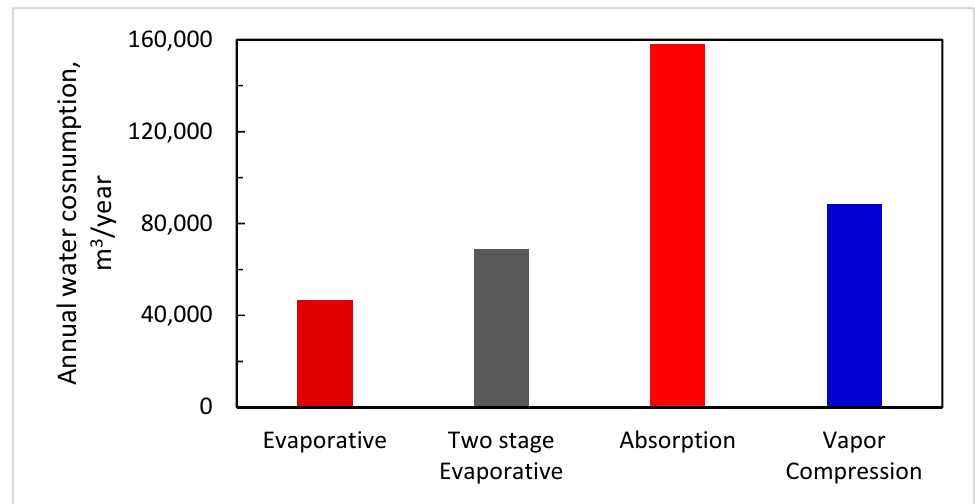
Figure 17. Water consumption of different inlet cooling systems.